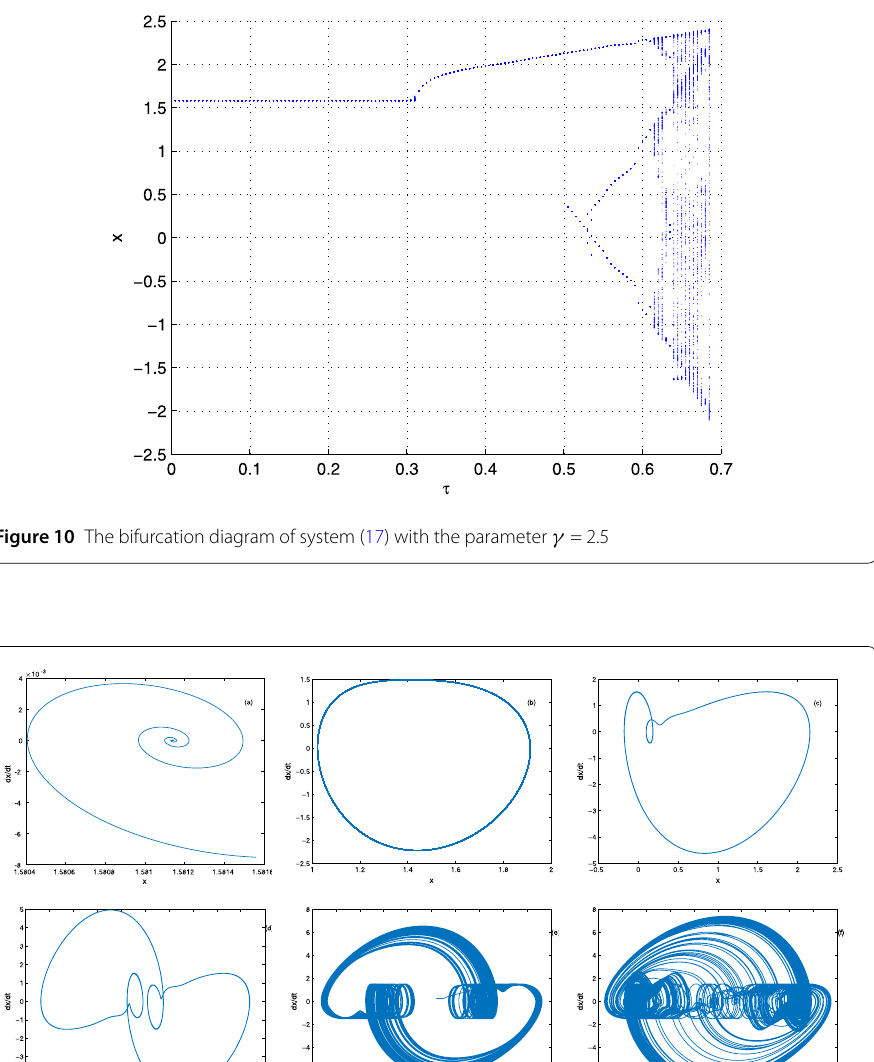
bifurcation, and the bifurcation diagram is shown in Fig. 12. According to the numerical simulations and Fig. 12, the following conclusions are found. The system is asymptotically stable for τ ∈ [0,0.26). And the limit cycle of period-1 becomes unstable and a period-2 cy- cle appears at τ = 0.42. Further period doubling occurs at τ = 0.43 (period-2 to period-4). Through a period doubling sequence, the system enters into the chaotic region at τ = 0.51. Then, the system enters into the divergent region at τ = 0.57. A phase plane representa- tion in the representative x – dx / dt plane for different τ is shown in Fig. 13, which shows the following characteristics: stability ( τ = 0.17), period-1 ( τ = 0.3), period-2 ( τ = 0.43), period-4 ( τ = 0.46), and chaos ( τ = 0.52 and τ =